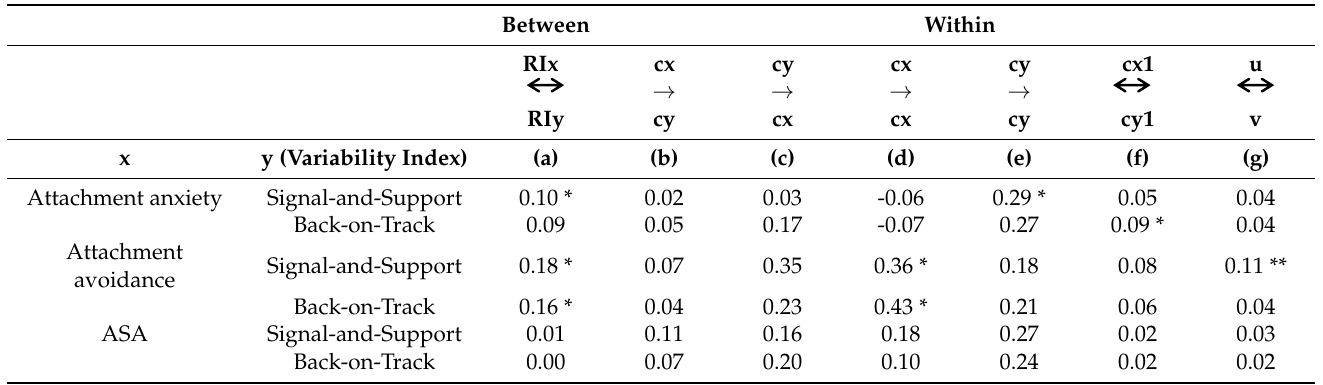
Table 6. RI-CLPM results with Attachment anxiety, Attachment avoidance and ASA. Table 5. RI-CLPM results with Trust.